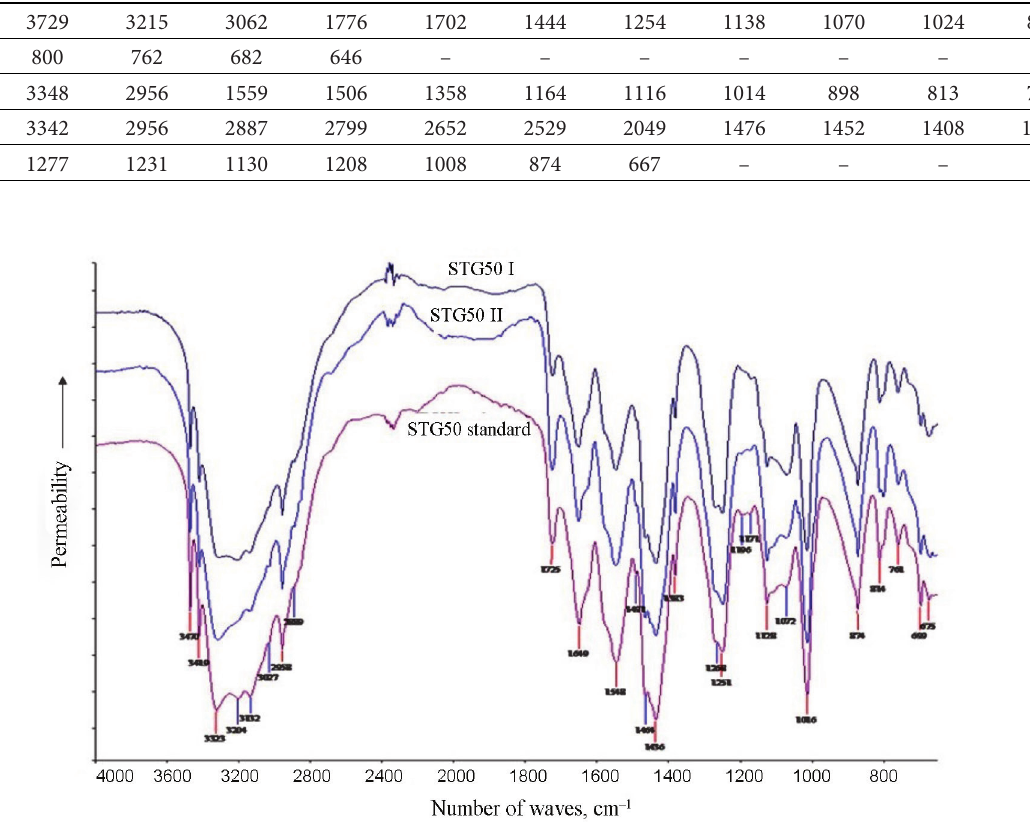
Figure 7. Intumescent fire protective coating STG50 samples of FT-IR spectra: STG50 standard – control samples, STG50 I – the coating was aged by I regime, STG50 II – aged by II regime